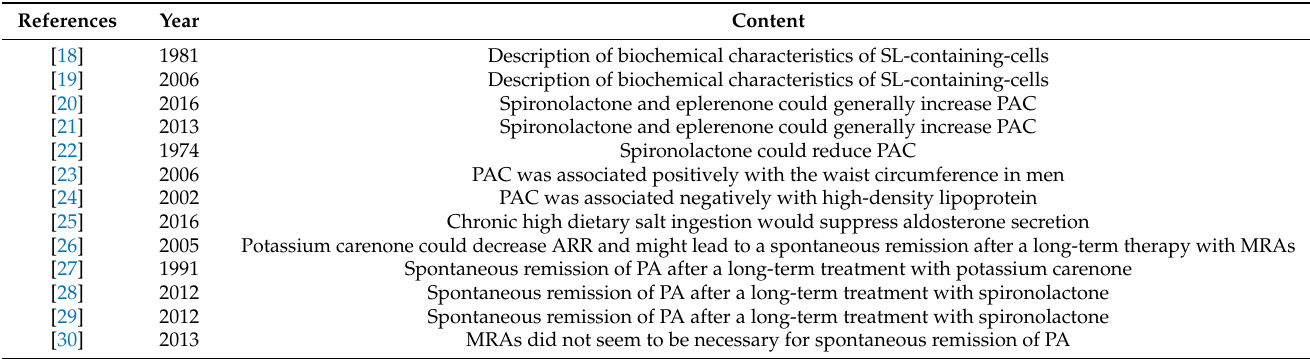
Table 2. Analysis of spontaneous remission of primary aldosteronism after long-term treatment with mineralocorticoid receptor